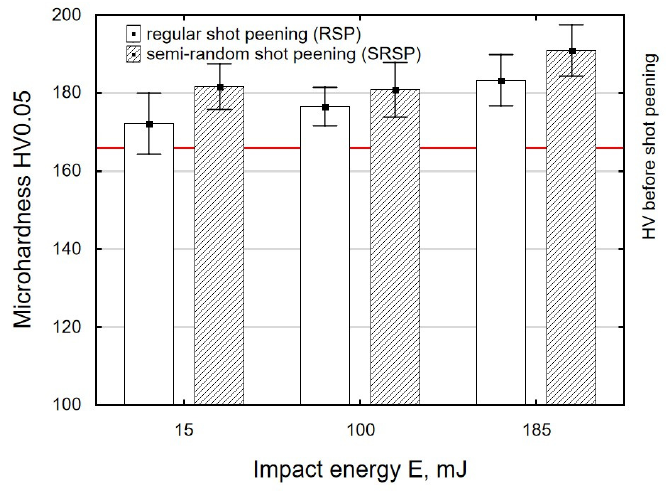
Figure 14. Impact energy versus surface microhardness (ball diameter D = 10 mm, distance between dimples x = 0.3 mm).